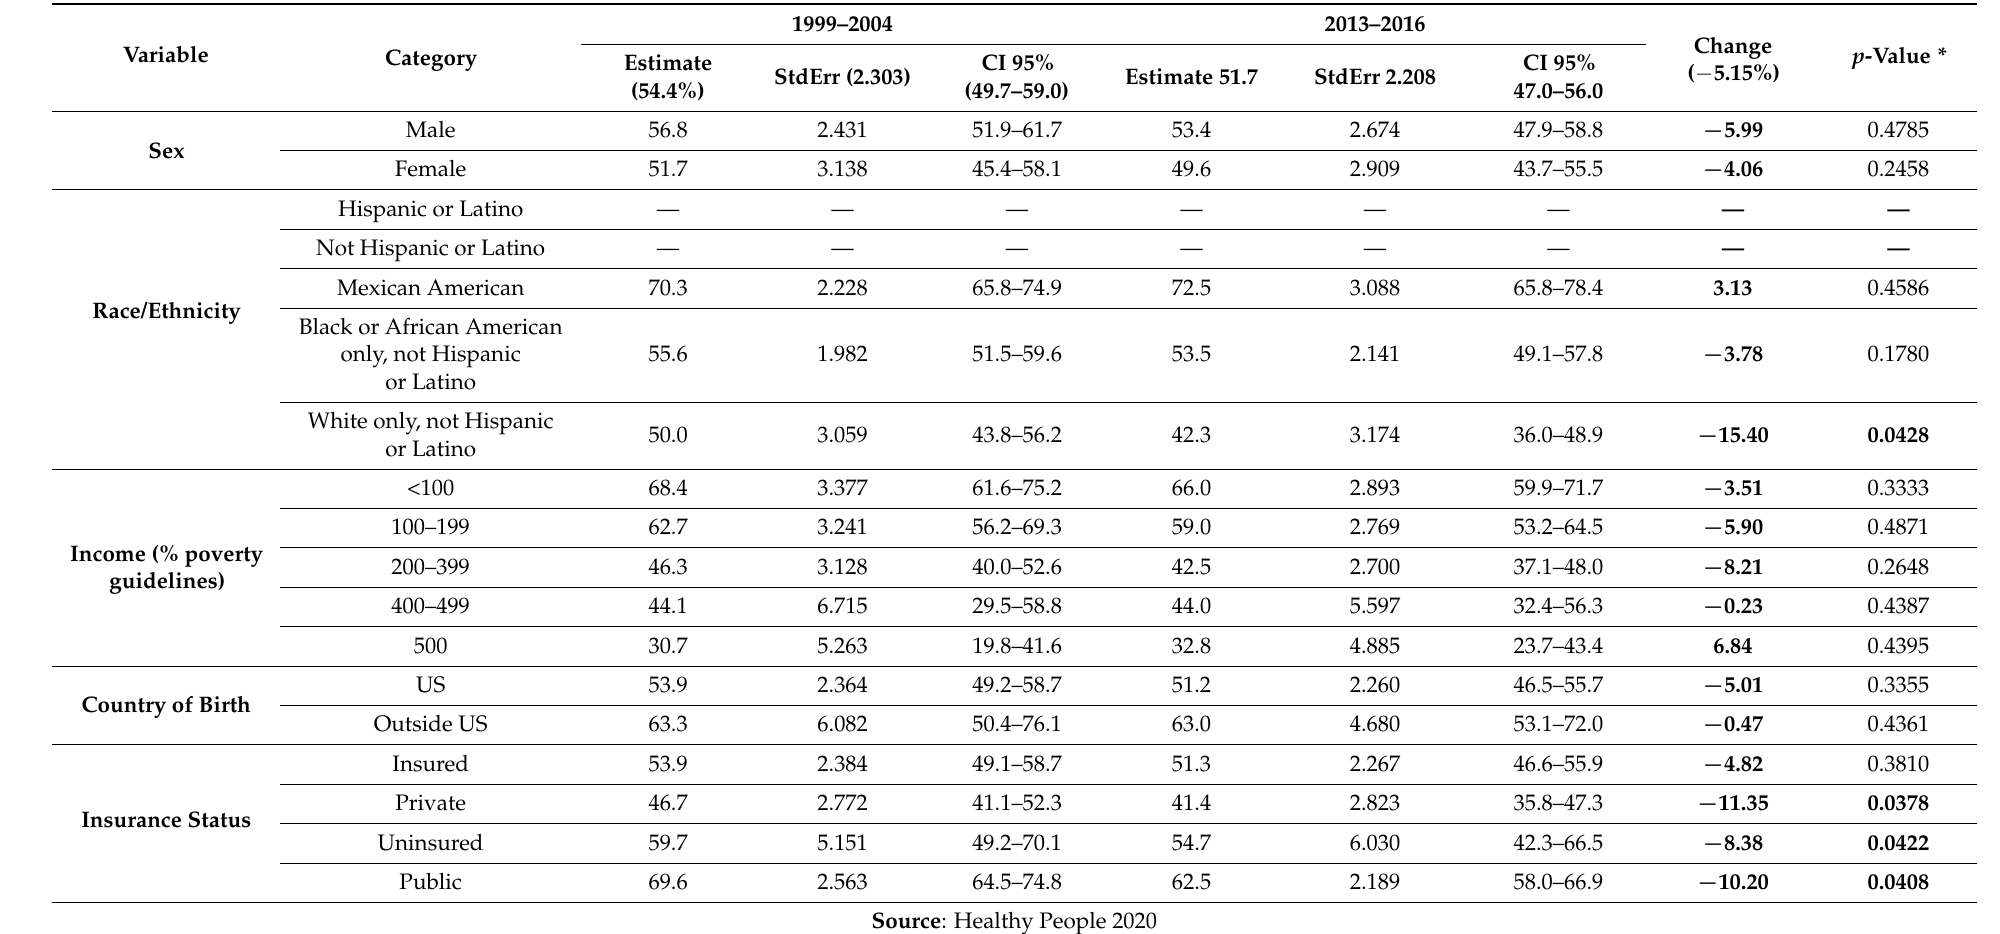
Table 3. Distribution of OH 1.2: caries 6–9 years, according to sociodemographic characteristics. Healthy People 2020. USA,